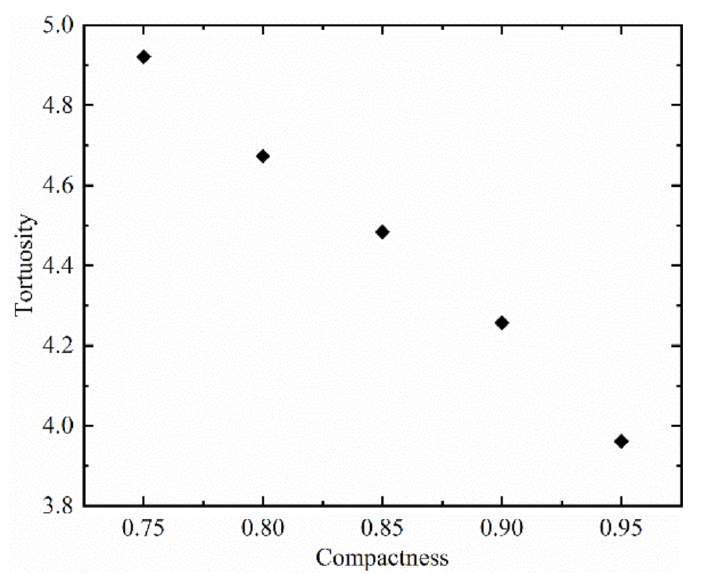
Figure 9. The evolution of the tortuosity with the